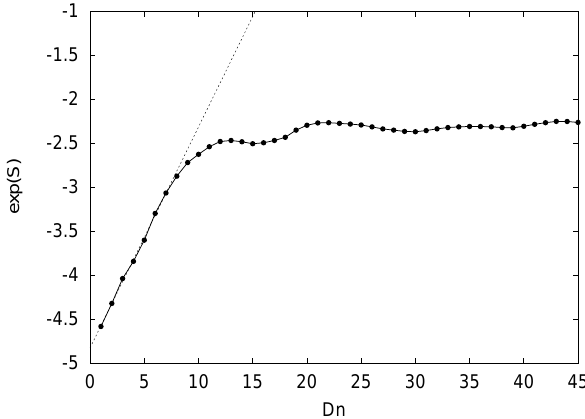
Fig. 10. The power spectrum of the times series with w = 0 . 001 . The first part of the spectrum corresponds to an abrupt decay and the second part corresponds to a slow decay, as shown by the dis- continuous lines.